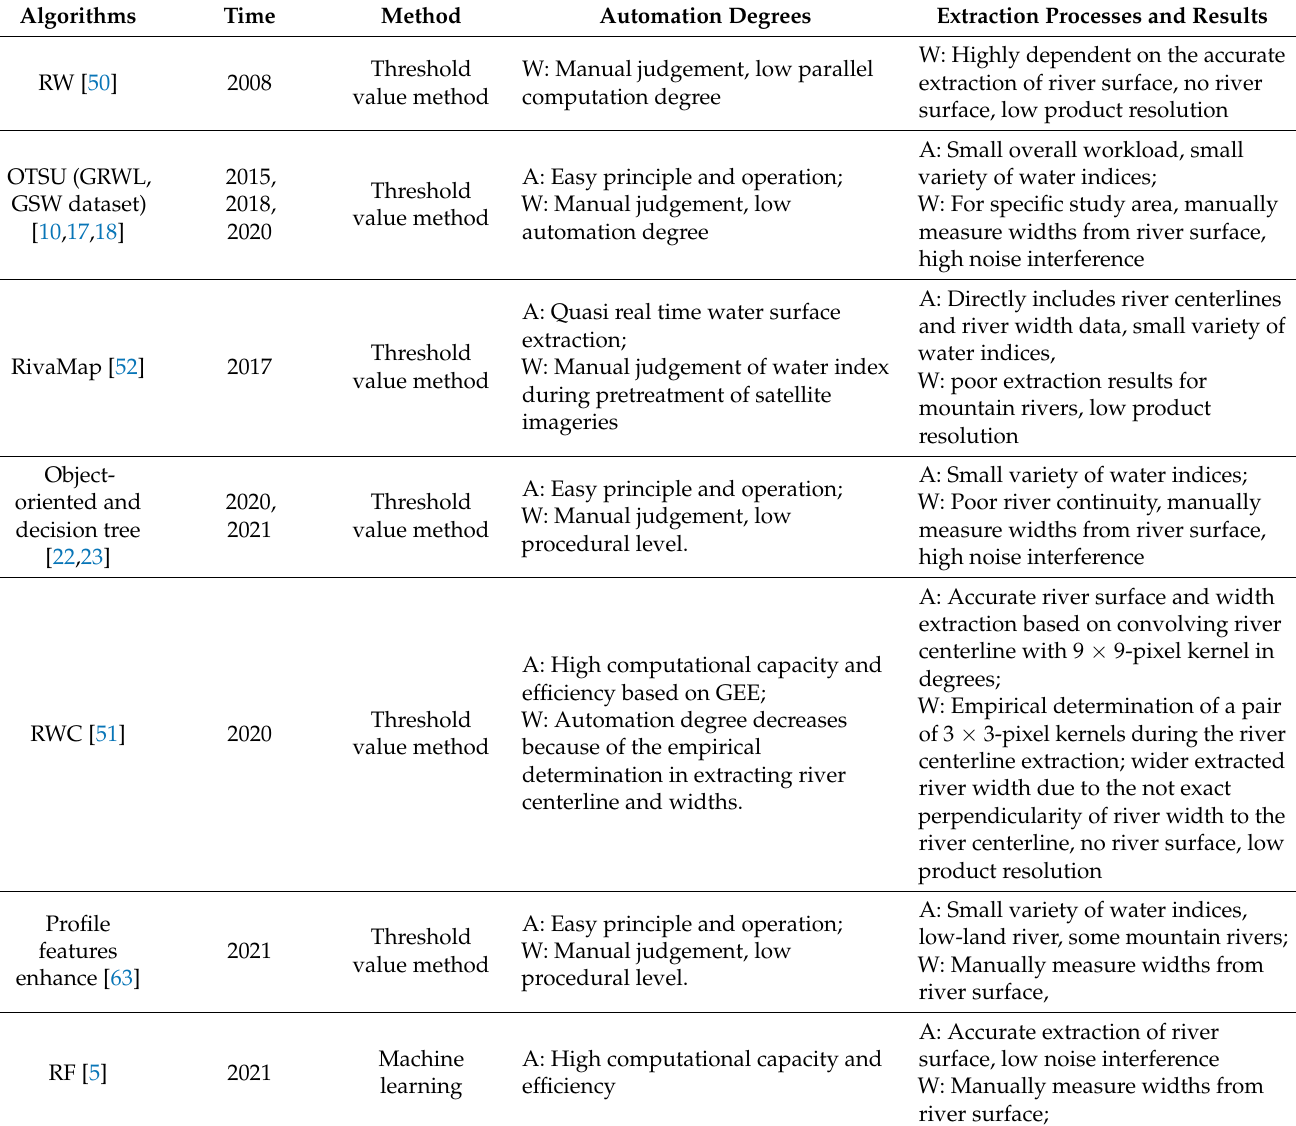
Table 3. Comparisons of existing methods in account of their automation degrees and extraction processes and